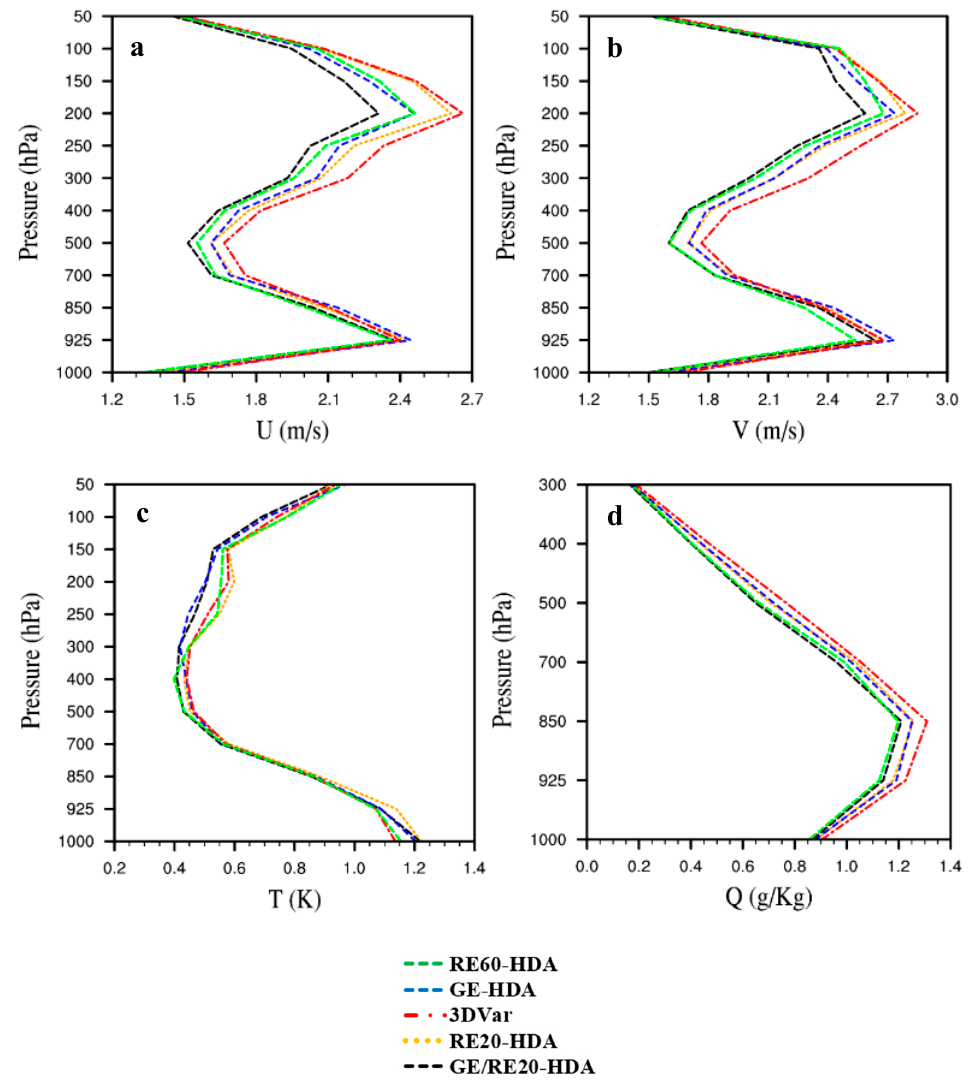
Figure 7. The vertical profiles of the average 6 h forecast root mean squared error (RMSE) against the European Centre for Medium-Range Weather Forecasts (ECMWF) analysis. ( a . Zonal wind (m/s); b . Meridional wind (m/s); c . Temperature (K); d . Water vapor mixing ratio (g/kg).)